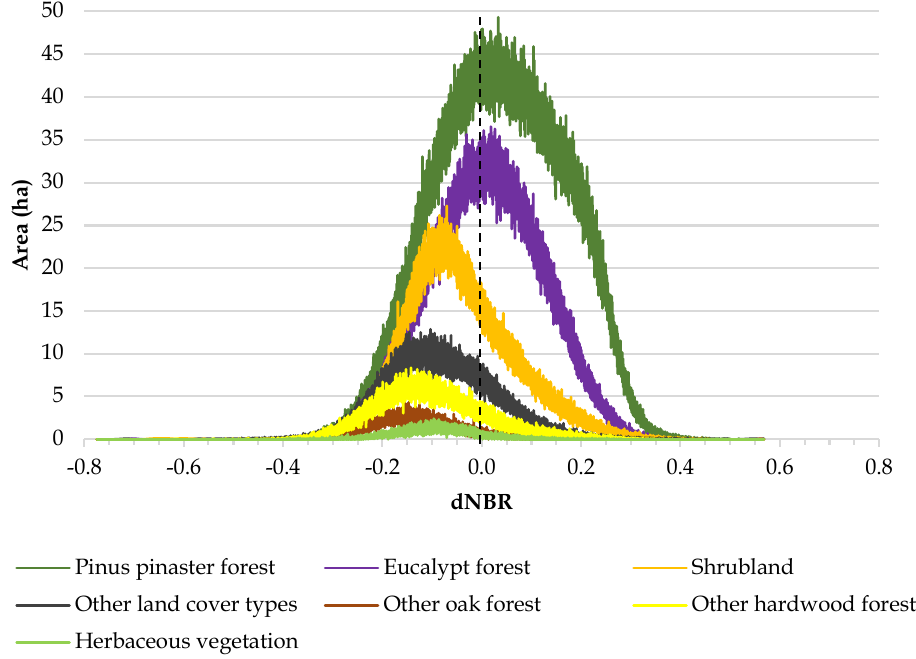
Figure 7. dNBR P6 distribution in the main LUC classes. The results of principal component analyses show different groupings of LUC classes of dNBR, specifically forest species with a minor area of representation (in absolute terms), for example forests of cork oak, holm oak, chestnut, Pinus pinea , and other conifers. Associ- ated with these LUC classes, other LUC classes are affected by wildfires, in particular the crop land cover types (olive groves and agroforestry). LUC classes with more area affected by wildfires tend to group in the PCA at higher linkage distances (Figure 8). These results reflect the different regeneration capacity in time of the different species ( Pinus pinaster , eucalyptus, and shrubland).